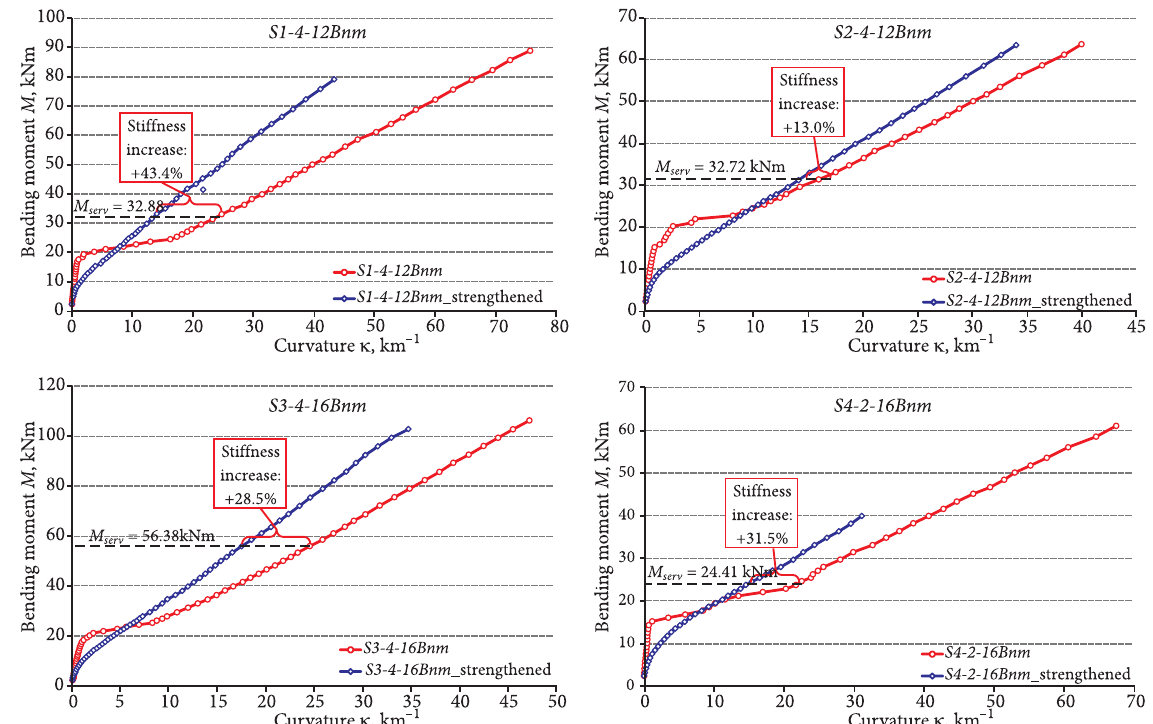
Fig. 6. Moment-curvature diagrams of the beams with BFRP reinforcement before and after